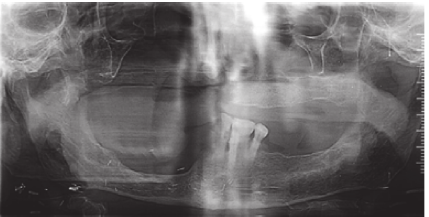
Figure 3: Postsurgical orthopantomograph revealing right side